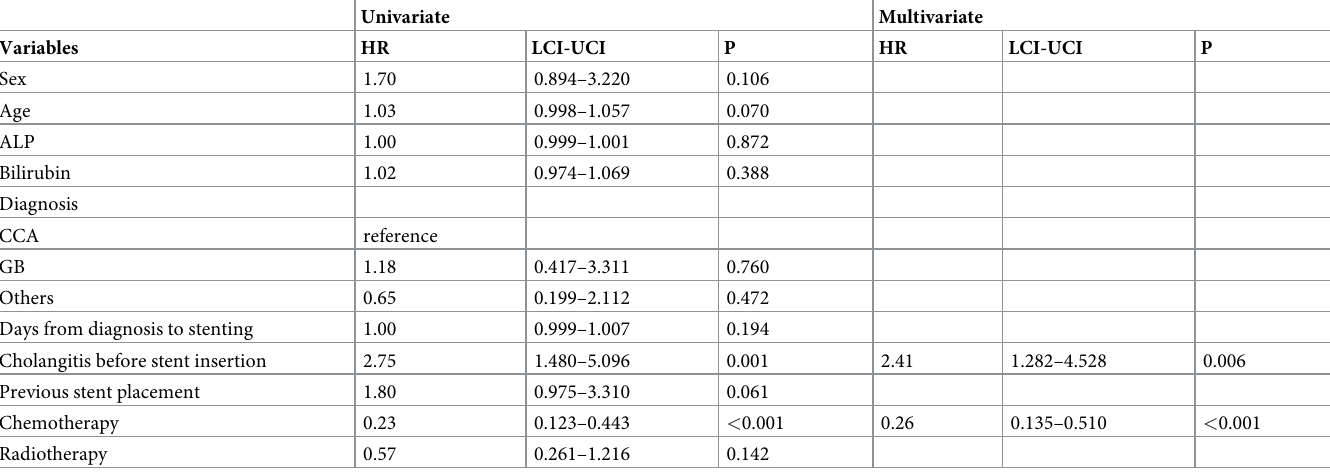
Table 3. Univariate and multivariate analysis of risk factors of stent